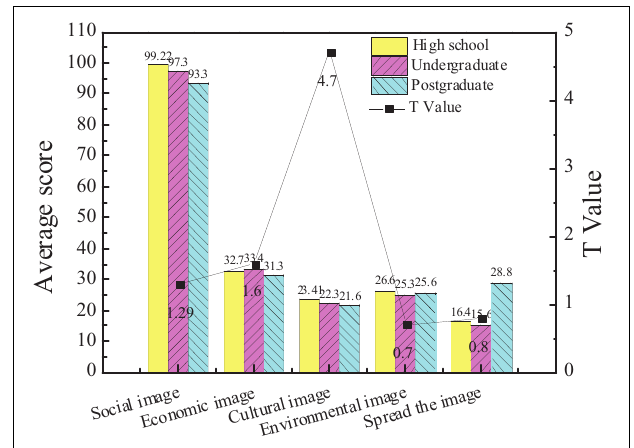
FIGURE 2 | Comparison of the attention to urban images between male and female entrepreneurs.